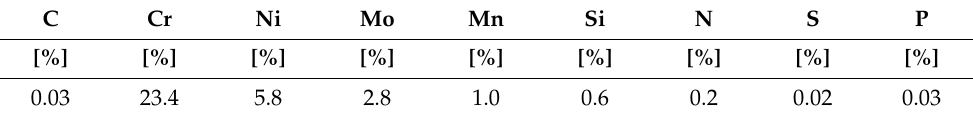
Figure 9. The rake face wear for CC2 cutting insert and EDS analyzer of chemical constitution. Table 4. The chemical constitution on build-up cutting edge with the EDS analyzer [%mass].